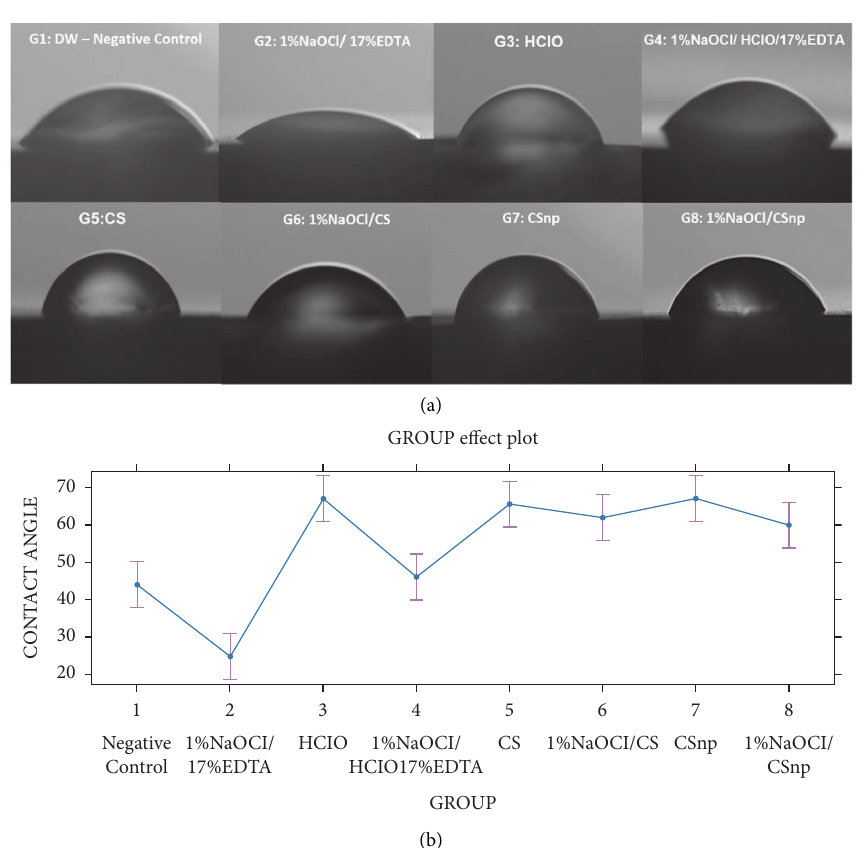
Figure 2: Representative images of wettability. (a) Model in vitro with sessile drop on the treated root surface, with each irrigation group as follows: negative control; 1% NaOCl+17% EDTA; 0.025% HOCl; 1% NaOCl +0.025% HOCl +17% EDTA; 0.2% CS; 1% NaOCl +0.2%CS; CSnp; and 1% NaOCl +CSnp. (b) Statistical lineal model with wettability values for the irrigation